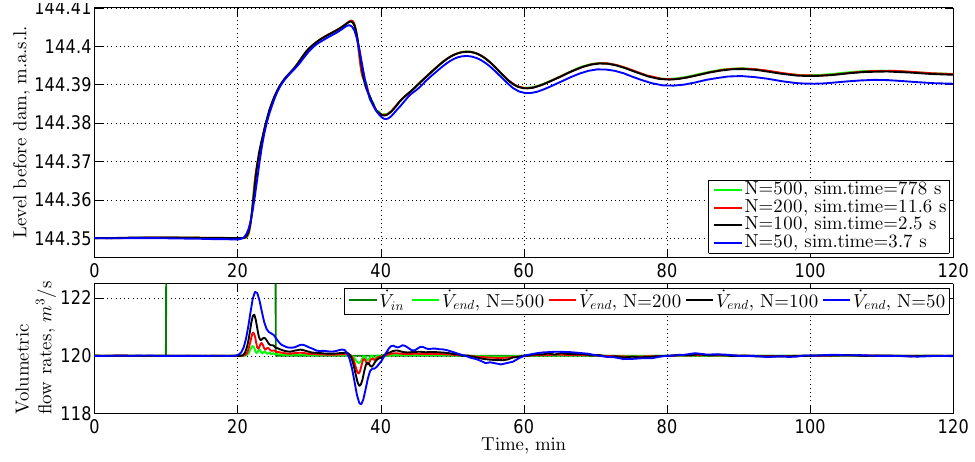
Figure 10: Comparison of how the simulation results depend on the number of